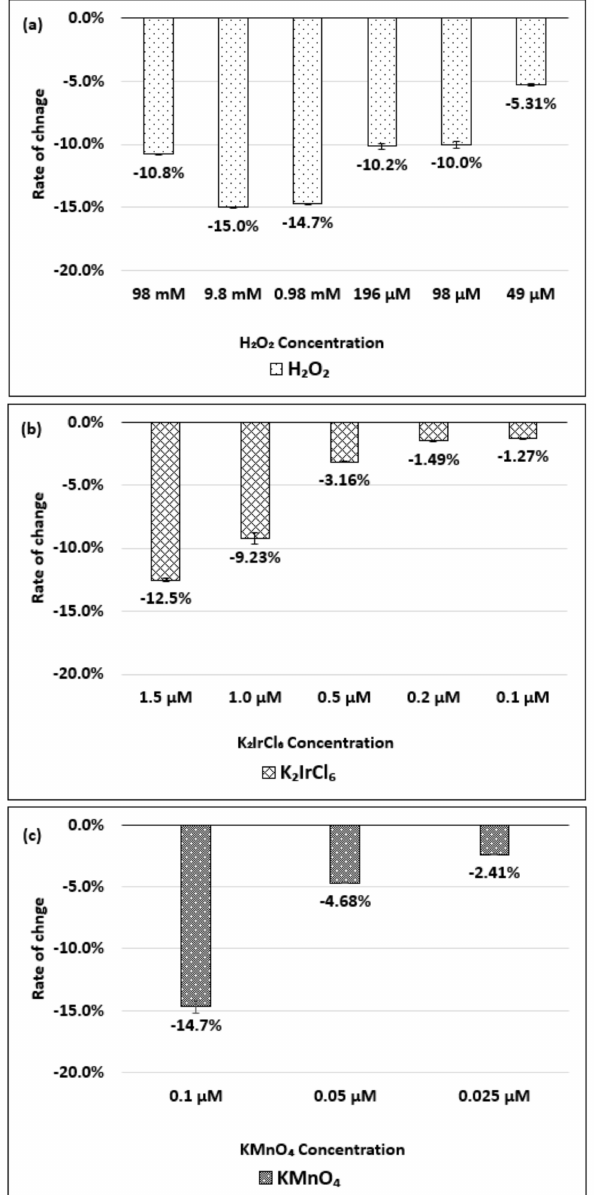
Figure 6. Absorbance change for the (8,7) chirality of the dsDNA-HiPco SWNT complex, relative to the initial state, based on the concentration of the ( a ) H 2 O 2 , ( b ) K 2 IrCl 6 , and ( c ) KMnO 4 . The data are presented as the average of three independent